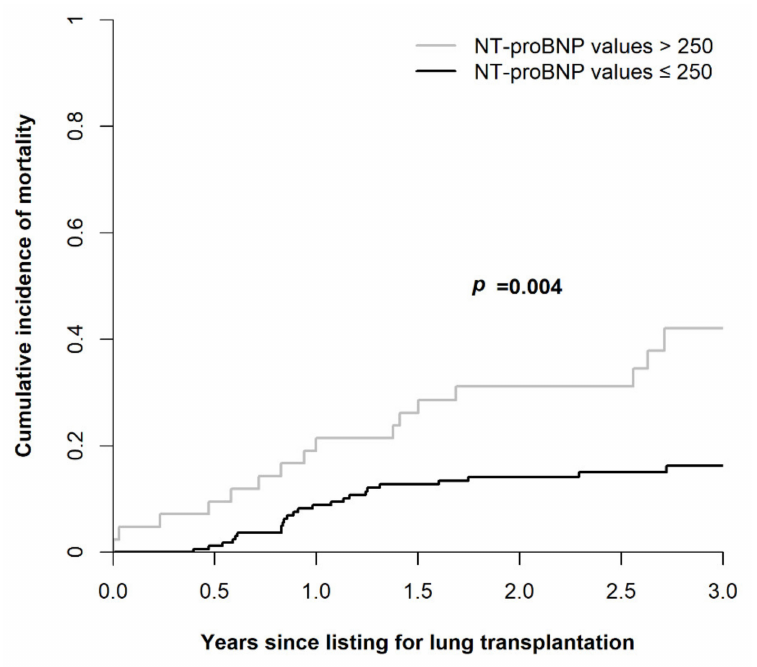
Figure 3. Cumulative incidence of mortality since listing for lung